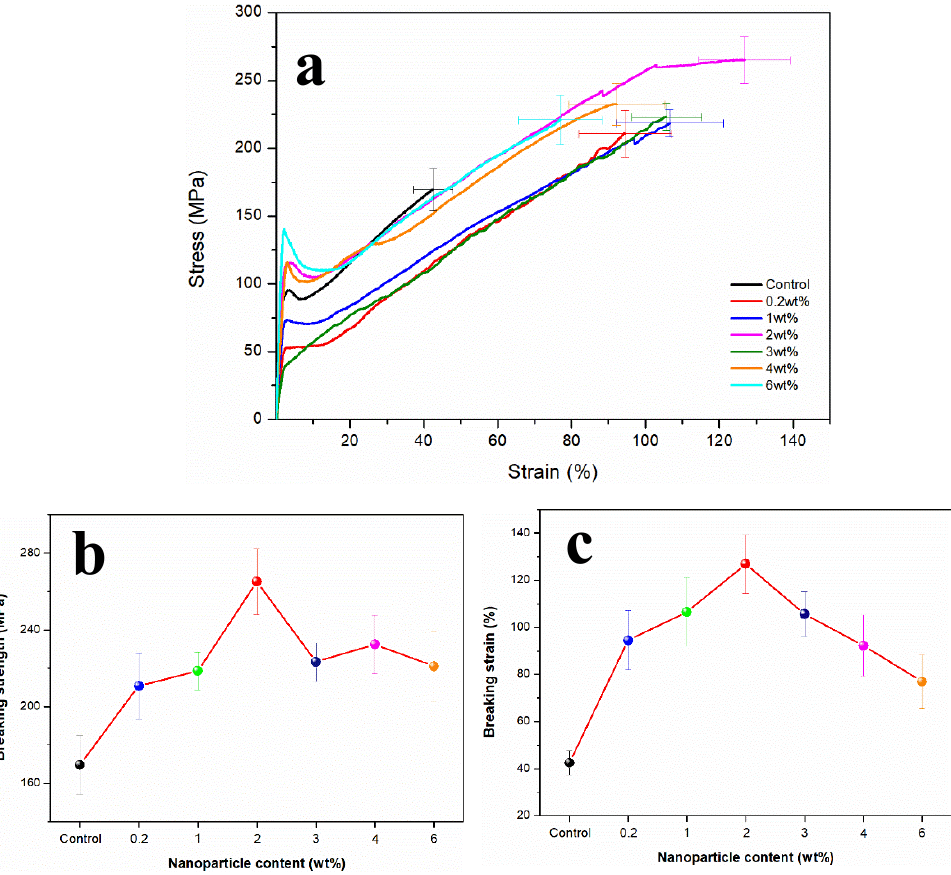
Figure 5. ( a ) Stress–strain curves; ( b ) breaking strength; ( c ) breaking strain of RSF/MoS 2 NPs hybrid fibers with different MoS 2 NP contents. Table 3. The mechanical properties of RSF/MoS 2 NPs hybrid fibers.